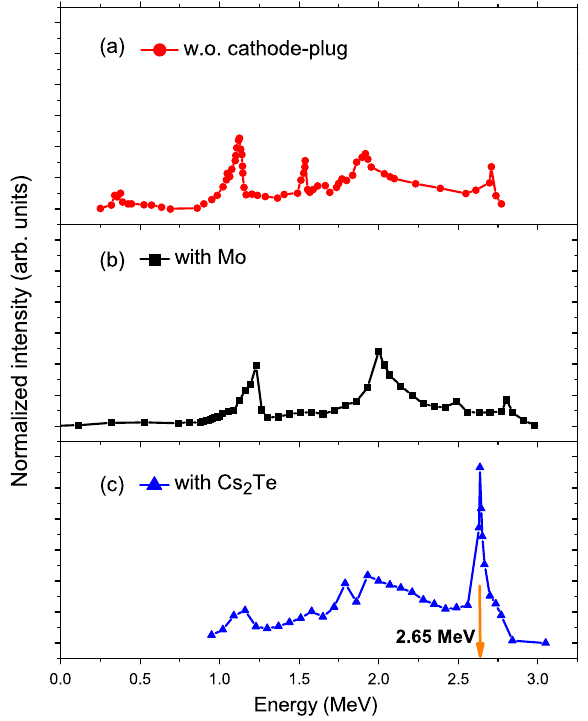
FIG. 6. Energy spectra of the dark current from the SRF gun ¼ 16 . 2 MV = m. The intensity is normalized to the with E z: max total dark current. The curve in (a) represents the case only from the Nb cavity. Part (b) shows the result of the cavity with Mo plug, and part (c) is from the case of the cavity with Cs 2 Te photocathode. The orange arrow points out the measured photoelectron energy.